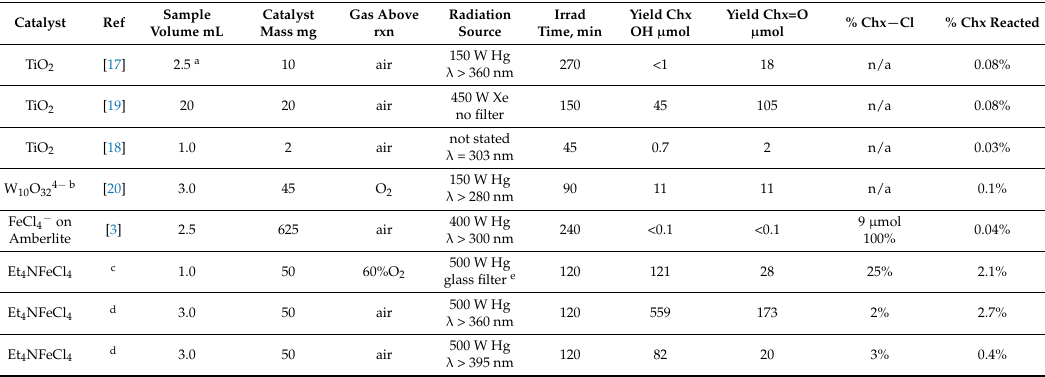
Table 12. Product yield after extended radiation of cyclohexane (containing 0.5% acetic acid and 1 mg Bu 4 NBr per mL) in the presence of Et 4 N[FeCl 4 ], with literature data for other catalysts in neat cyclohexane.